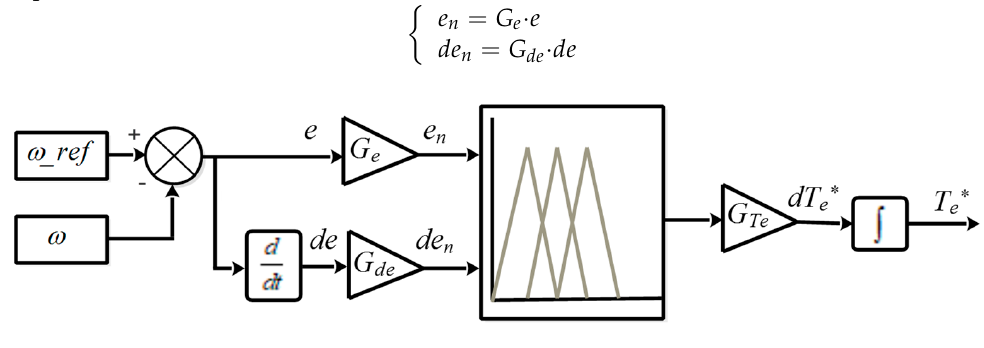
Figure 12. Fuzzy logic speed controller.